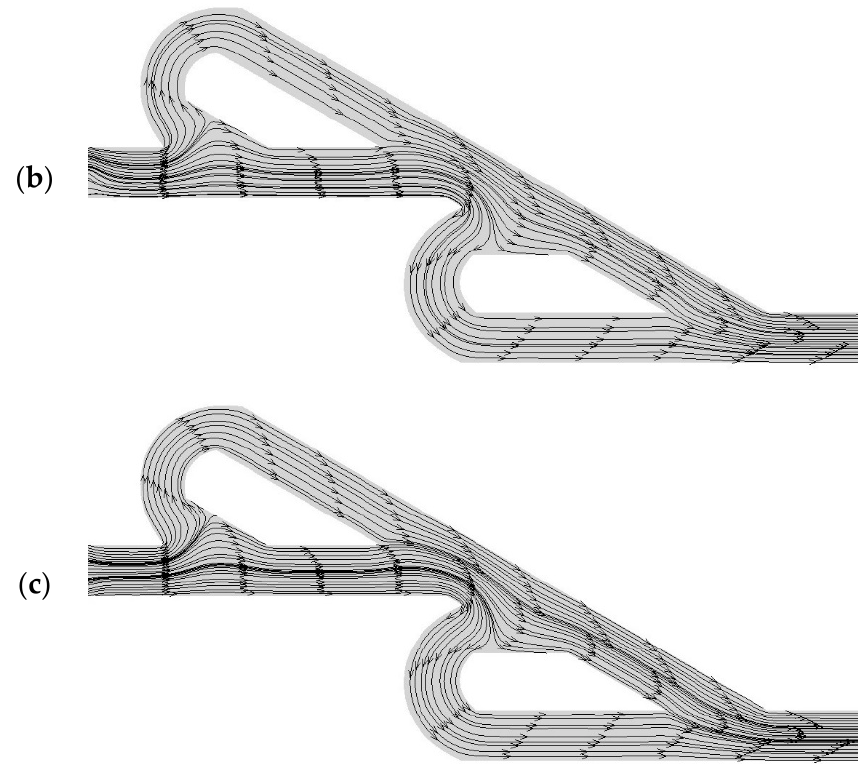
Figure 5. Streamlines into the micromixer for velocity ratios equal to ( a ) V p /V c = 20, ( b ) V p /V c = 10, and ( c ) V p /V c = 1.